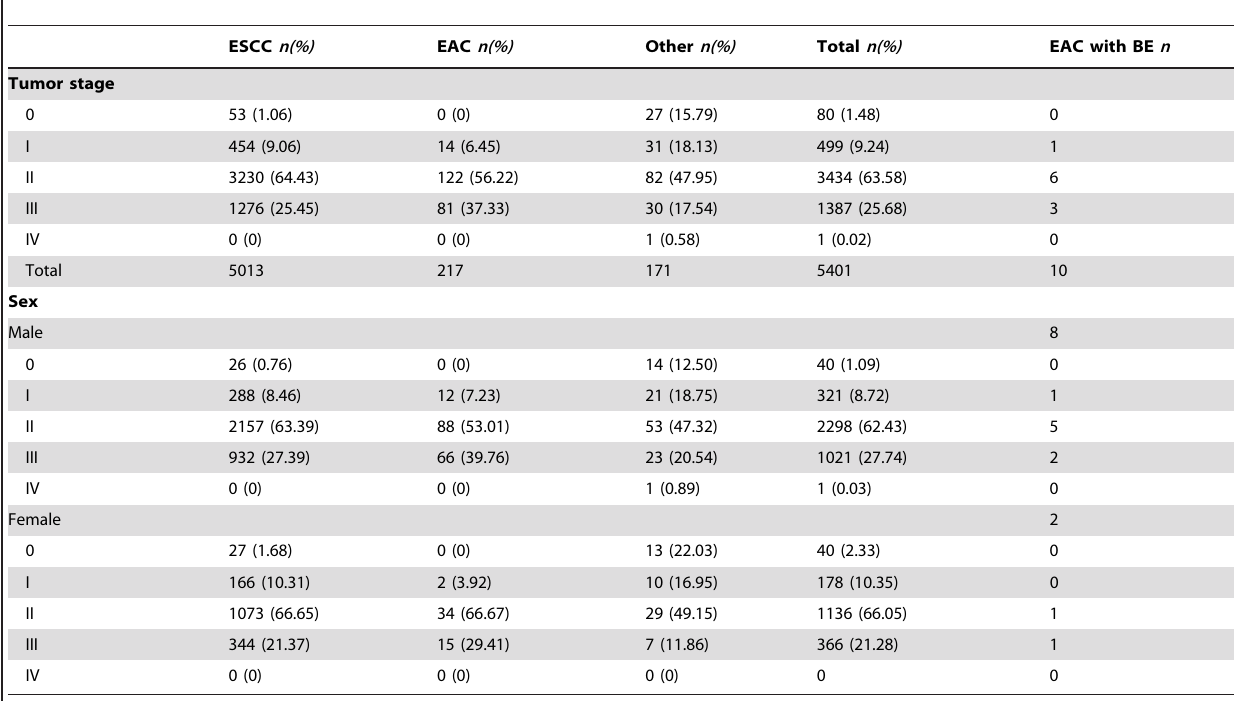
Table 3. Distribution of esophageal squamous cell carcinoma (ESCC) and esophageal adenocarcinoma (EAC) by tumor stage and